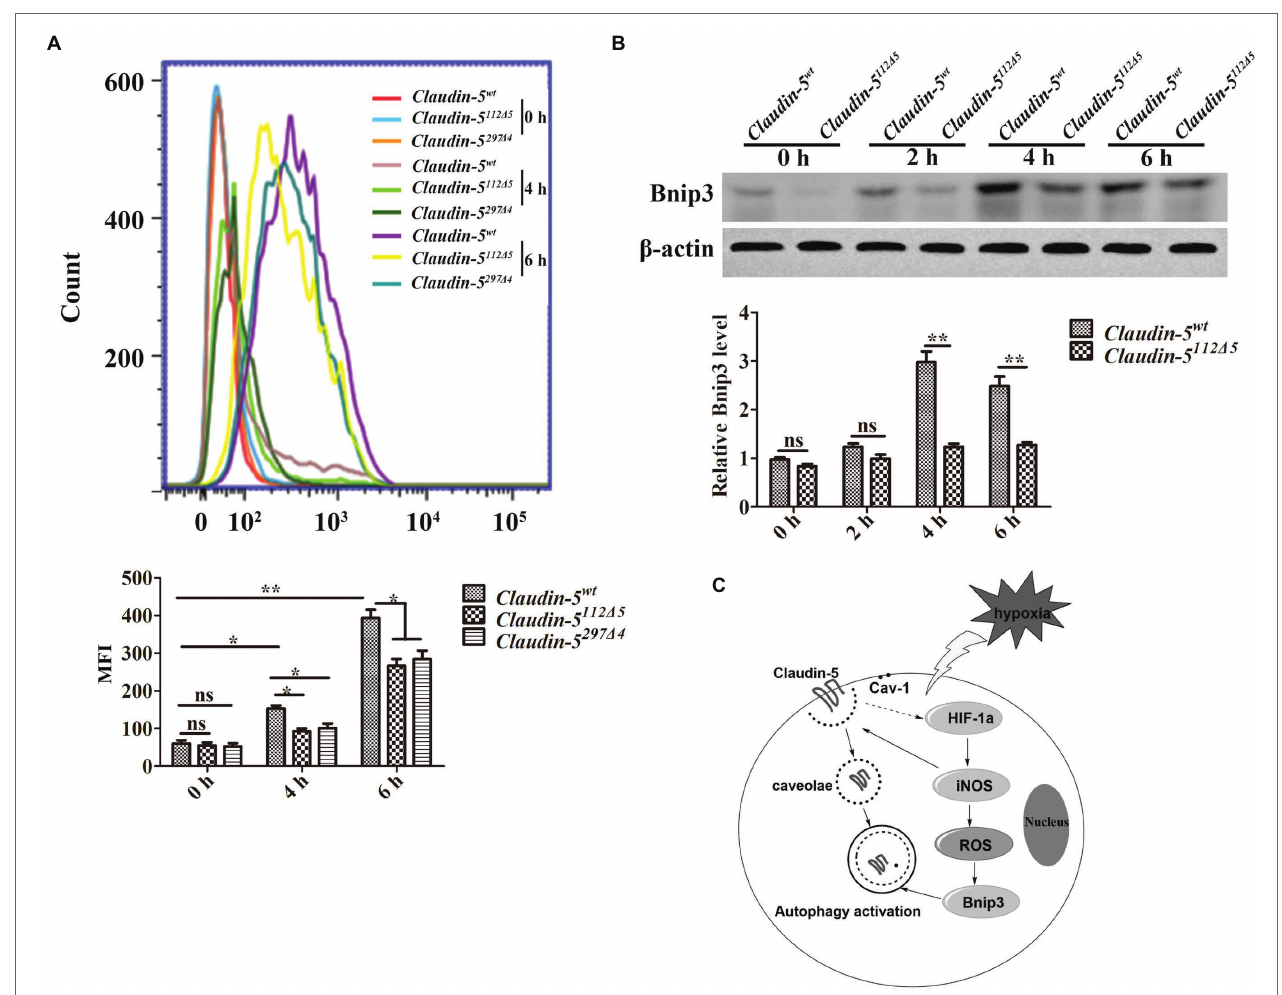
FIGURE 5 | Reactive oxygen species (ROS) production drives BCL2/adenovirus E1B 19 kDa protein interacting protein 3 (Bnip3) expression in brain microvascular endothelial (bEnd.3) cells in response to hypoxia. (A) ROS analysis by flow cytometry and quantitative analysis of ROS intensity. (B) Western blot analysis of Bnip3. Mean ± SD, n = 3 independent experiments per group. * p < 0.05 and ** p < 0.01. (C) Schematic illustrating the mechanism that Claudin-5 is involved in autophagy in cerebral vascular endothelial cells in the early stage of